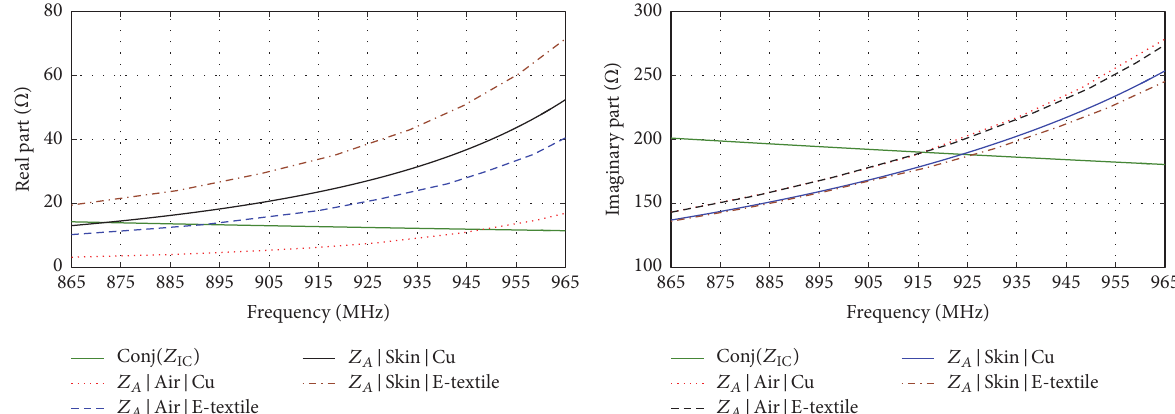
Figure 2: Simulated antenna impedance and the conjugate of the microchip impedance from the parallel RC equivalent circuit model ( 𝑅 = 2.85 k Ω , 𝐶 = 0.91 pF).